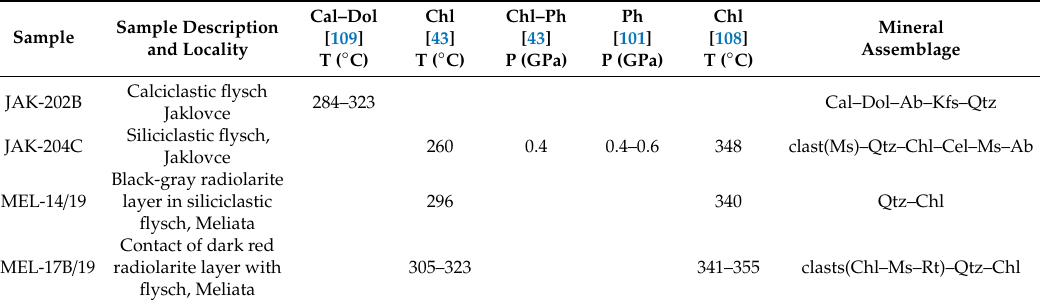
Table 12. Meliata Unit rock P – T estimates from combined geothermobarometry.